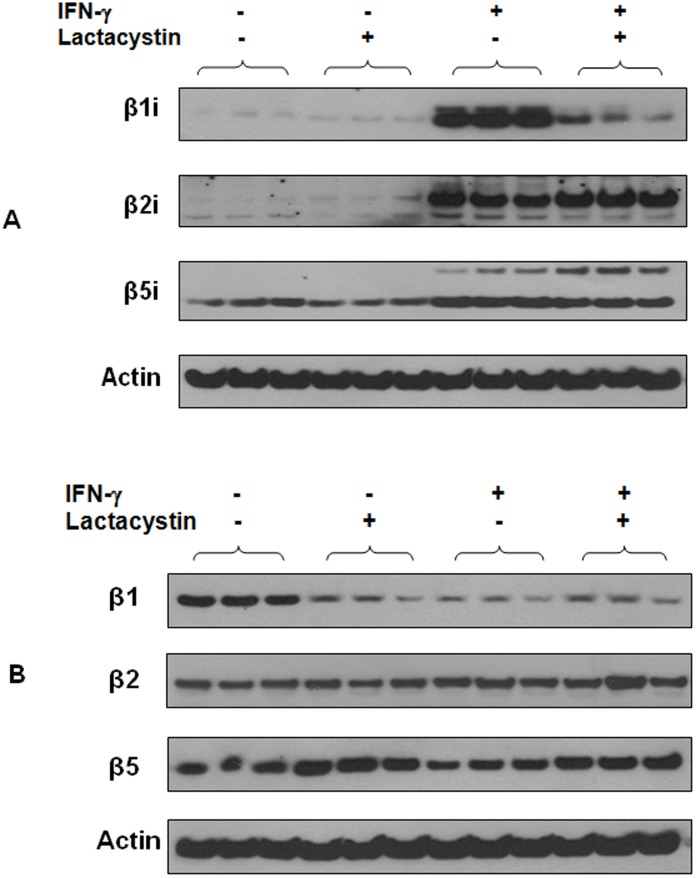
Effect of lactacystin pre-treatment on the expression of β1i, β2i, β5i, β1, β2 and β5 in HSG cells.(A) Western blot analysis of β1i, β2i and β5i in HSG cells (n = 3 per group). (B) Western blot analysis of β1, β2 and β5 in HSG cells (n = 3 per group). At each experimental condition, three cell lysates samples obtained from three separate wells of the 6-well plate were analyzed.